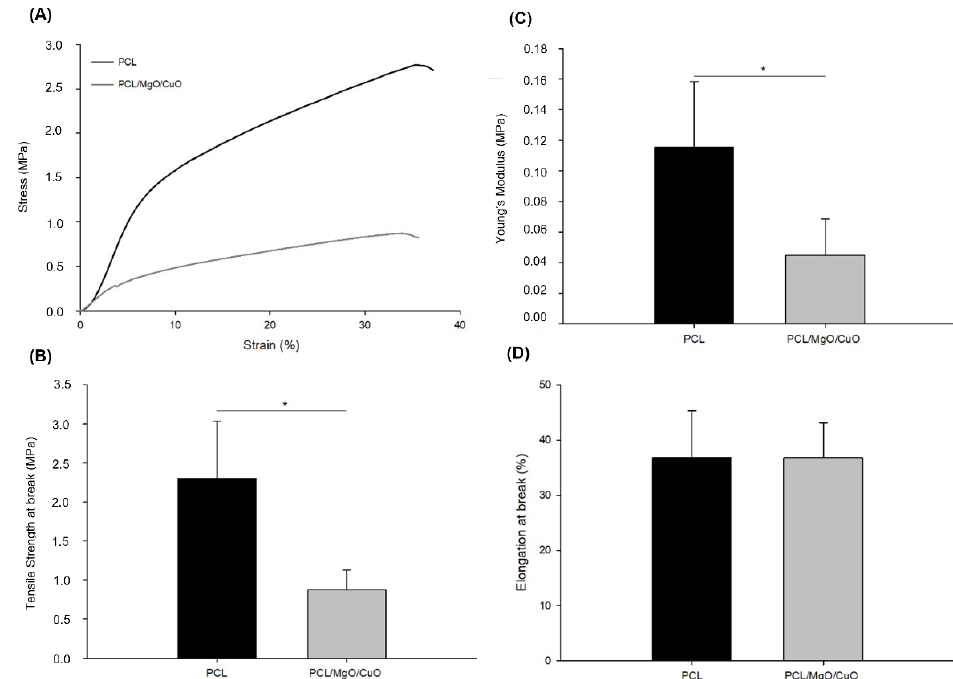
Figure 8. Mechanical characterization of PCL electrospun meshes (black) and PCL electrospun meshes dopped with MgO and CuO NPs (grey). ( A ) stress – strain representative curves; ( B ) Young’s Modulus; ( C ) tensile strength at break; and ( D ) elongation at break. Statistical significance for p ≤ 0.05 (*).